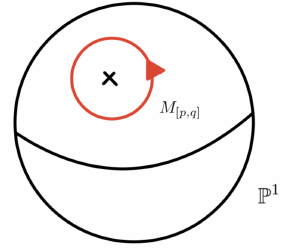
Figure 2 . Monodromy around a [ p, q ] 7-brane in F-theory on